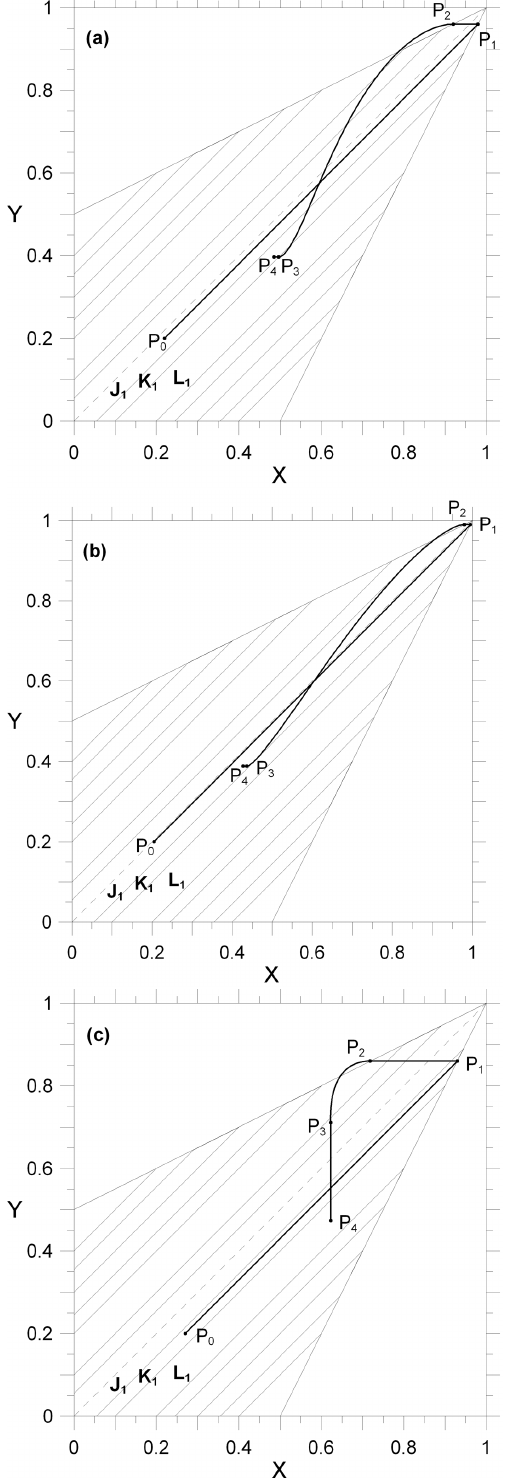
Fig. 3. Orbits of the system in the cases (a) p = − 0 . 02, (b) p = − 0 . 005 and (c) p =− 0 . 07 ( (cid:15) = 0 . 7, α = 1).